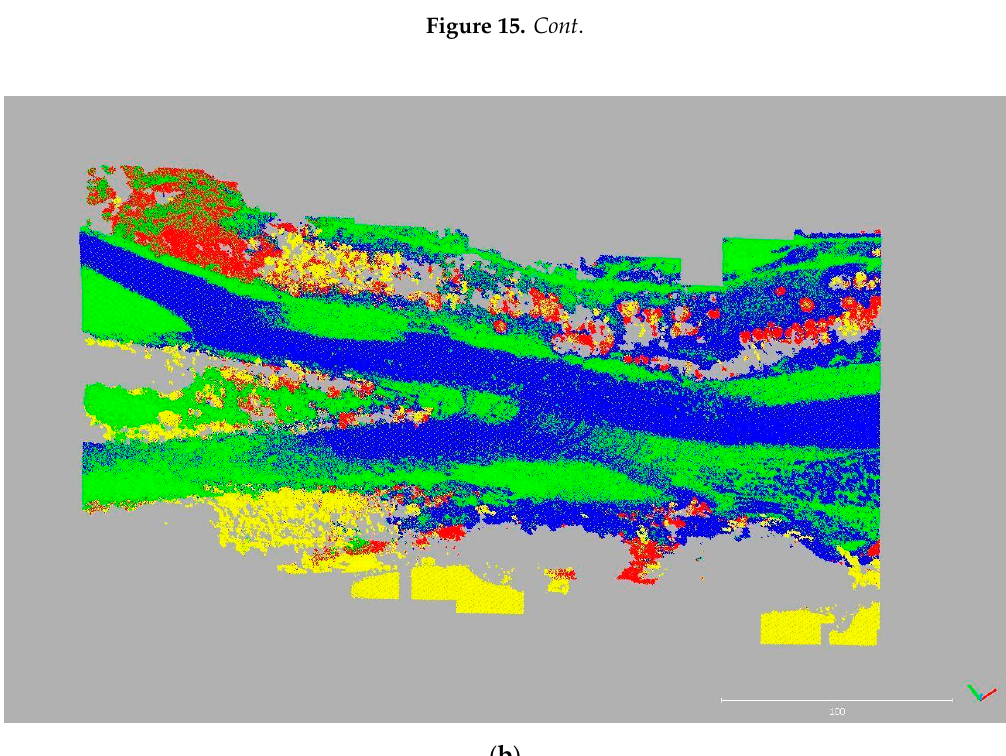
Figure 15. Testing dense point clouds result; ( a ) original RGB visualized and ( b ) the automatic ML algorithm classified dense point cloud where the water, gravel bars, vegetation and ground/soils are shown in blue, green, yellow and red colors, respectively.